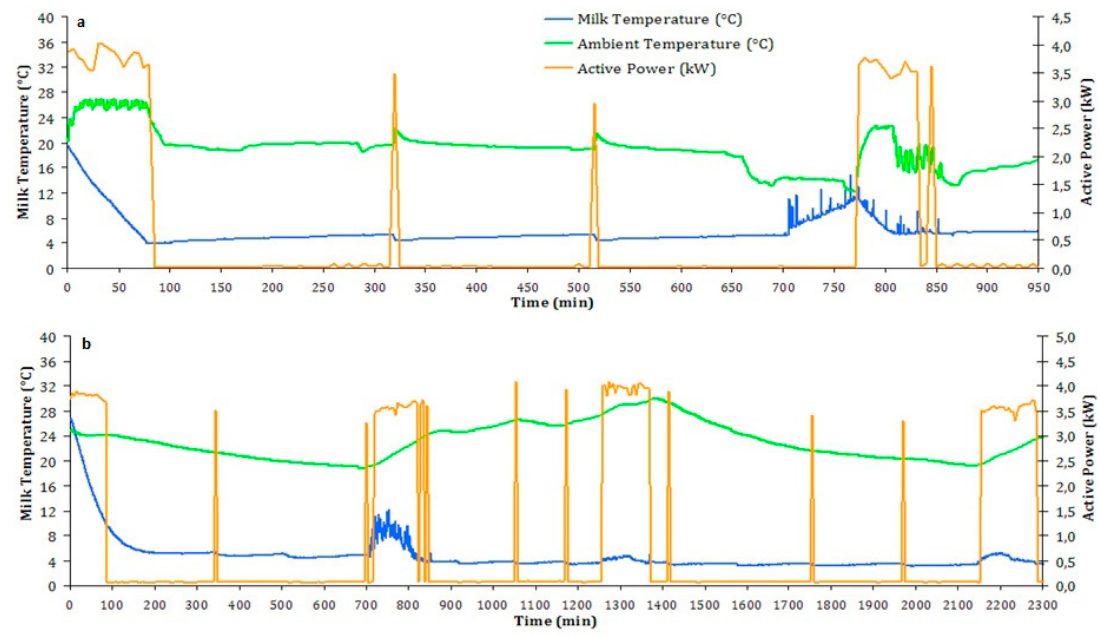
Figure 4. Power consumption monitoring of two MCSs. ( a ) Tank No. 21, volume 1055 L, monitored for 24 h over 2 cooling sessions; ( b ) Tank No. 22, volume 2500 l, monitored for 72 h over 4 cooling sessions. During the second cooling session of MCS No. 21, the refrigeration unit was started after the milking to perform another performance check with limited temperature fluctuations of the milk bulk (data not used for evaluating the MCS).